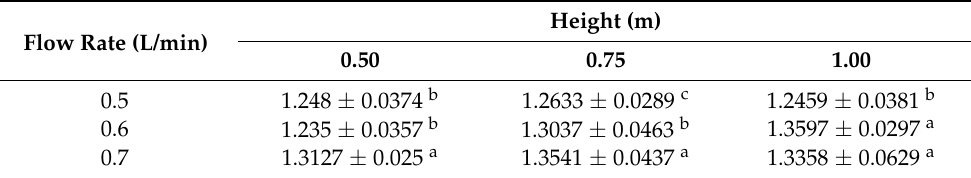
Table 5. Effect of the flow rates on